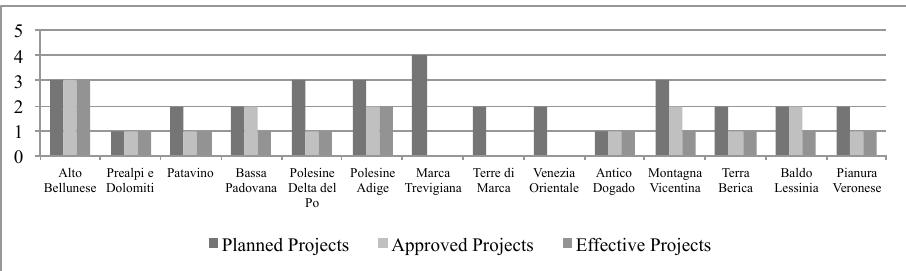
Figure 1. Comparison between planned, approved and effectively implemented TNC projects by LAG in Veneto Region, LEADER Axis programming